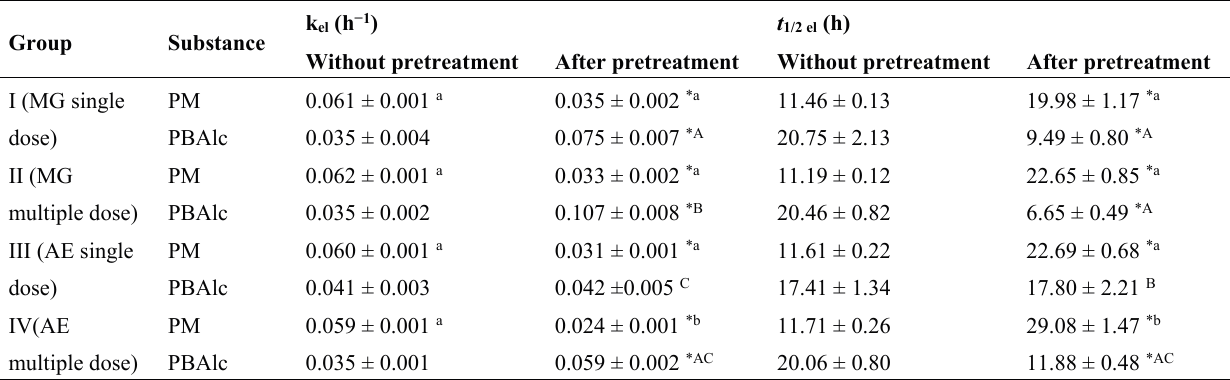
Figure 4. Semilog plasma concentration-time profiles of PBAlc and trans -PM during 8–22 h in rats receiving a single or multiple oral dose(s) of MG (40 mg/kg) and AE (100 mg/kg); ( A ) MG single dose; ( B ) MG multiple dose; ( C ) AE single dose; ( D ) AE multiple doses. Table 2. Elimination rate constants (k el ) † and elimination half-lives ( t 1/2 el ) † of PM and PBAlc in rats following a single and multiple dose(s) of MG and AE